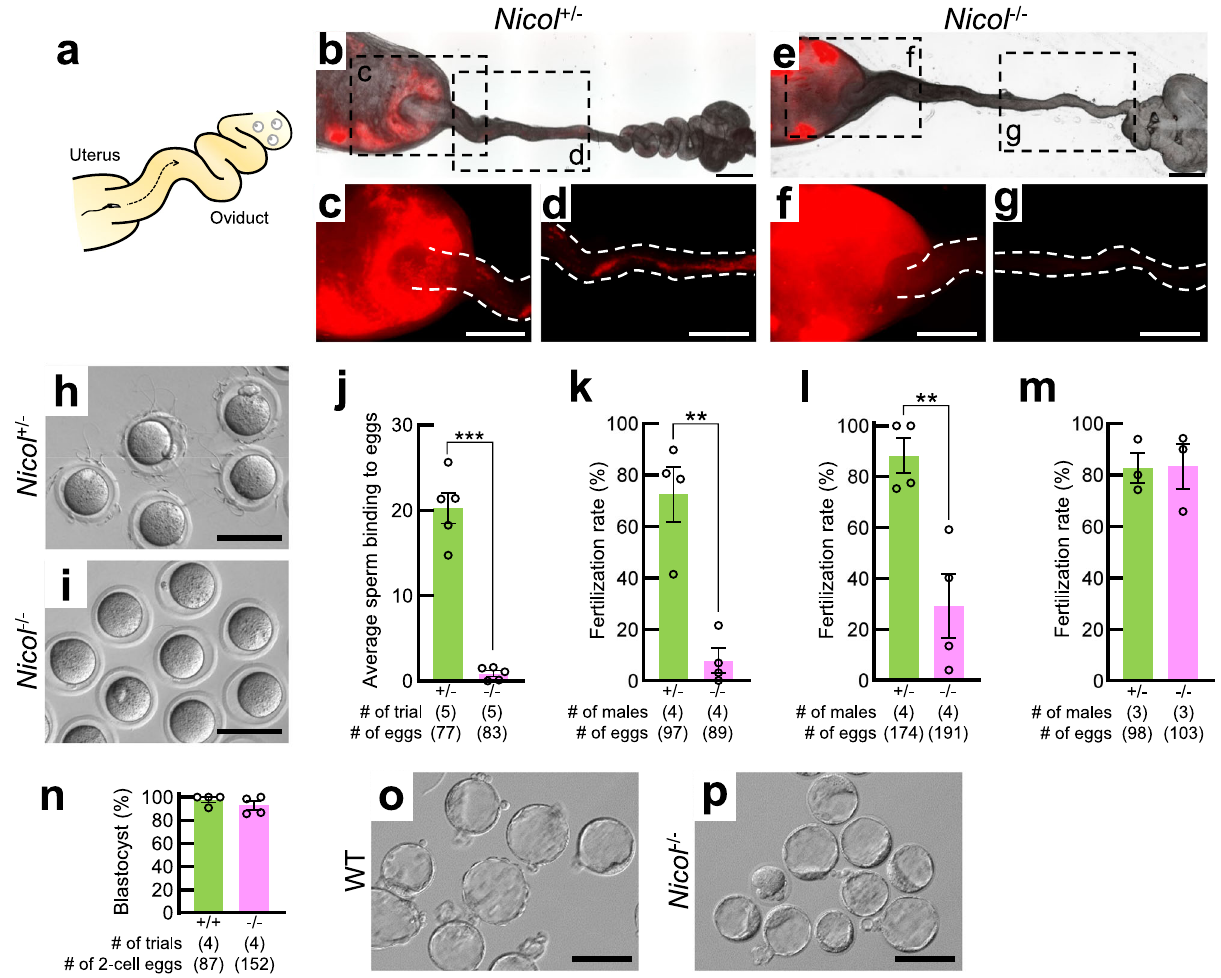
Fig. 2 | Defective sperm maturation blocks sperm migration into the oviduct resulting in male sterility in Nicol − / − mice. a Schematic representation of ejacu- lated sperm migrating from the uterus into the oviduct towards oocytes. b – g Migration of red fl uorescence-illuminated sperm from Nicol +/ − ( b – d ) and Nicol − / − ( e – g ) mice ejaculated into reproductive tract in WT females. Bars, 1mm. h , i Representative images of sperm – ZPbinding assayusing Nicol +/ − ( h )and Nicol − / − ( i ) sperm obtained from fi ve independent biological replicates. Bars, 100 µ m. j Sperm – ZP binding assay using sperm from Nicol +/ − (green columns) and Nicol − / − (pink columns) mice. Average and S.E.shown. k – m In vitrofertilization capacity of